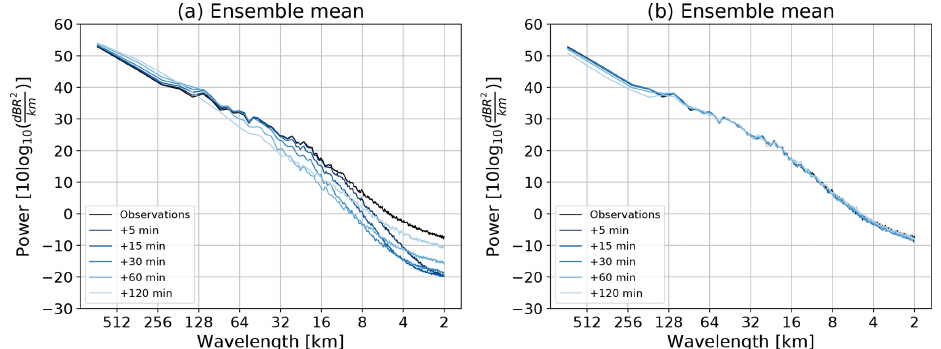
Figure 18. Spatial structure analysis of the ensemble mean forecast using (a) eight cascade levels and (b) one cascade level. Both experiments have an ensemble size of 24 members. MeteoSwiss event no. 3 was used.